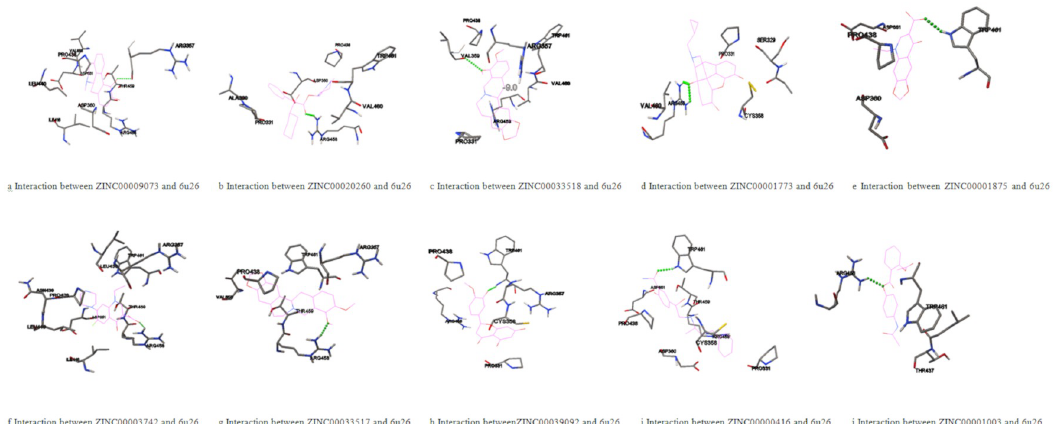
Fig 3. (a-j) Stick representation showing interactions between the top 10 molecules and target protein (PDB ID– 6U26).